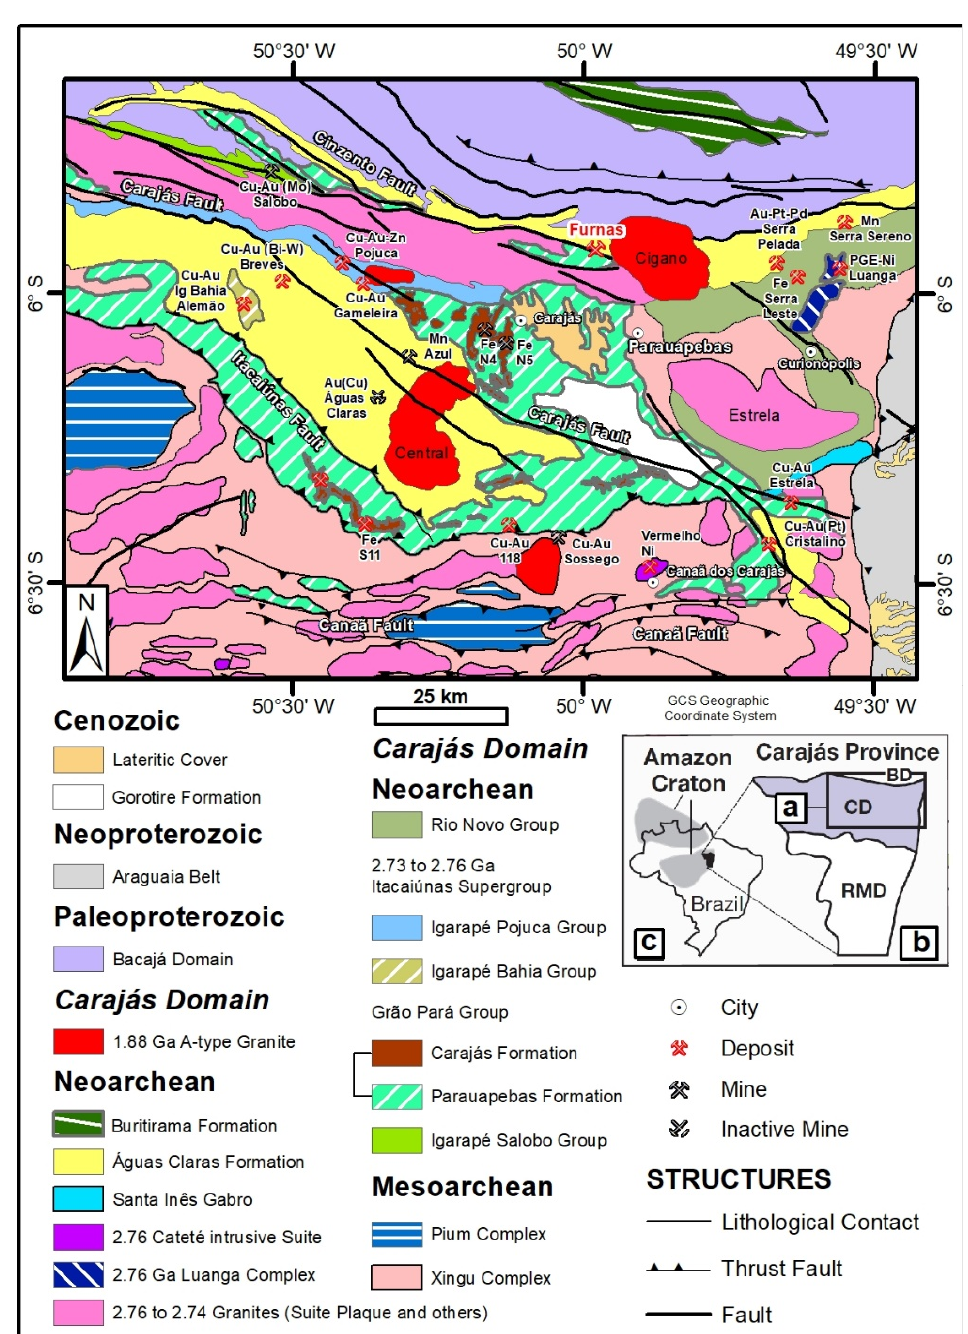
Figure 1. Geological map of the Carajás Mineral Province with the location of the Furnas deposit and the main Cu, Au, Fe, Mn, Ni, and Pt group element (PGE) deposits. ( a ) Location of the Carajás Geological Map in the regional setting. ( b ) Carajás Province map with the Carajás domain (CD) and Rio Maria domain (RMD). The Bacajá domain (BD) is located north of the Carajás domain. ( c ) Map of Brazil with the location of Carajás Province (in black) and the Amazon Craton (in gray) (Modified from DOCEGEO [35]; Araújo and Maia [36]; Barros and Barbey [37]; Vasquez et al. [38]; and Xavier et al. [27]).